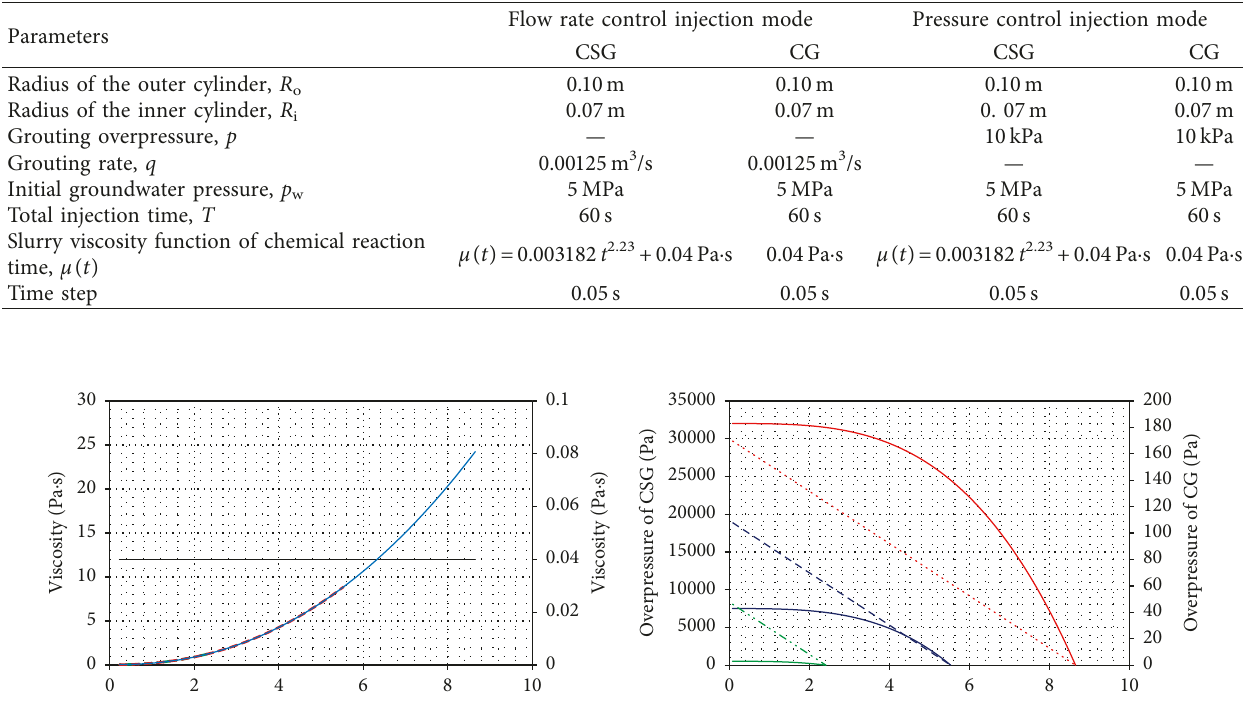
Table 1: Parameters adopted for the generation of the calculation and numerical simulation.